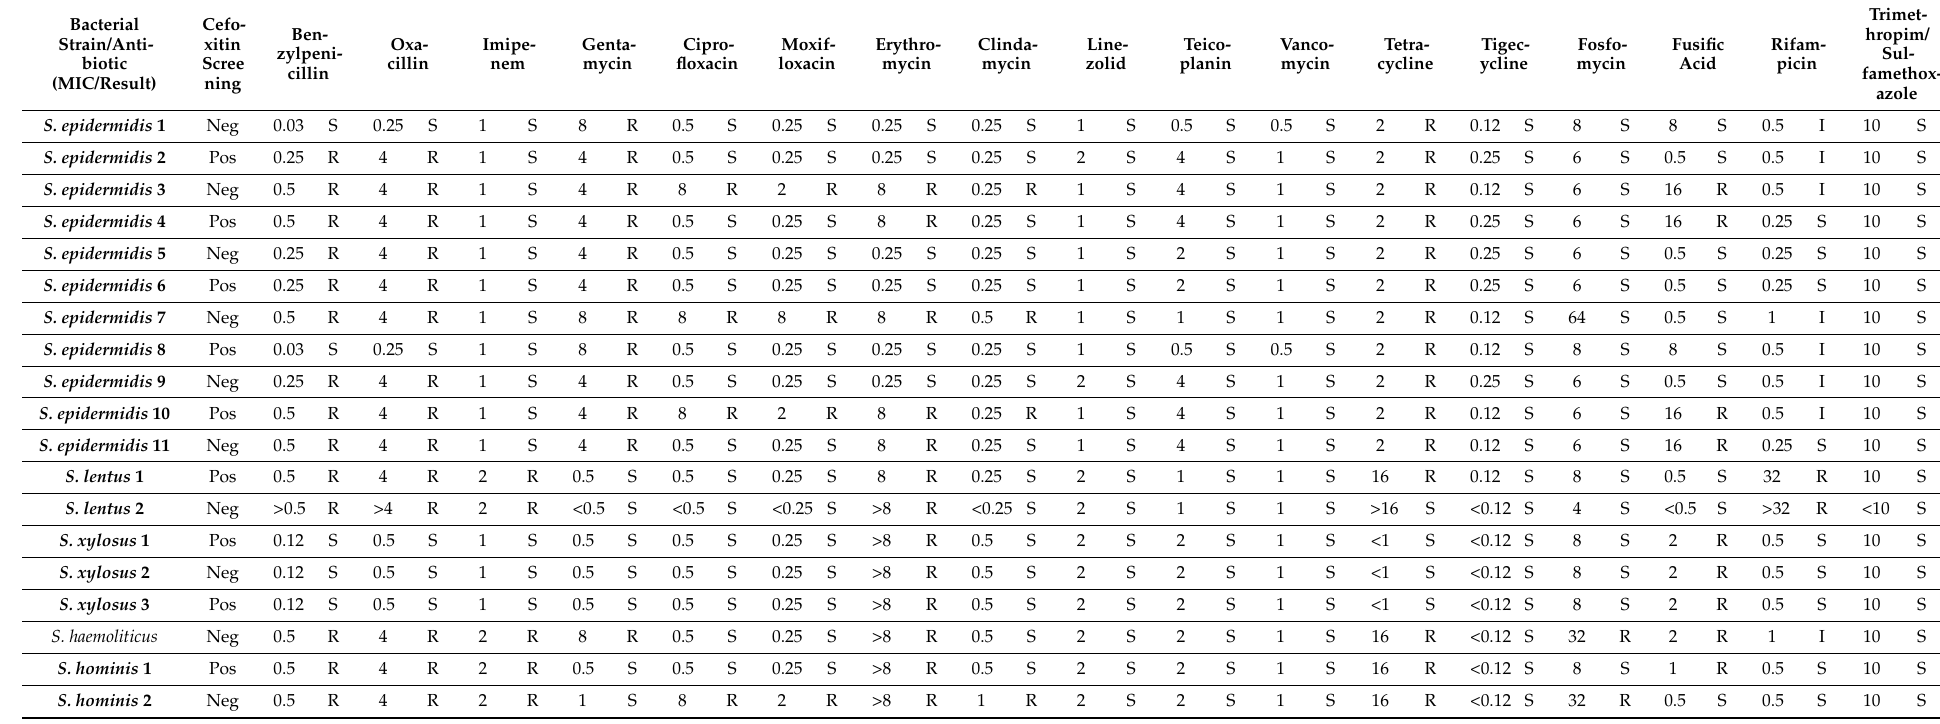
Table 4. MICs (mg/L) of antimicrobials for Coagulase-negative staphylococci